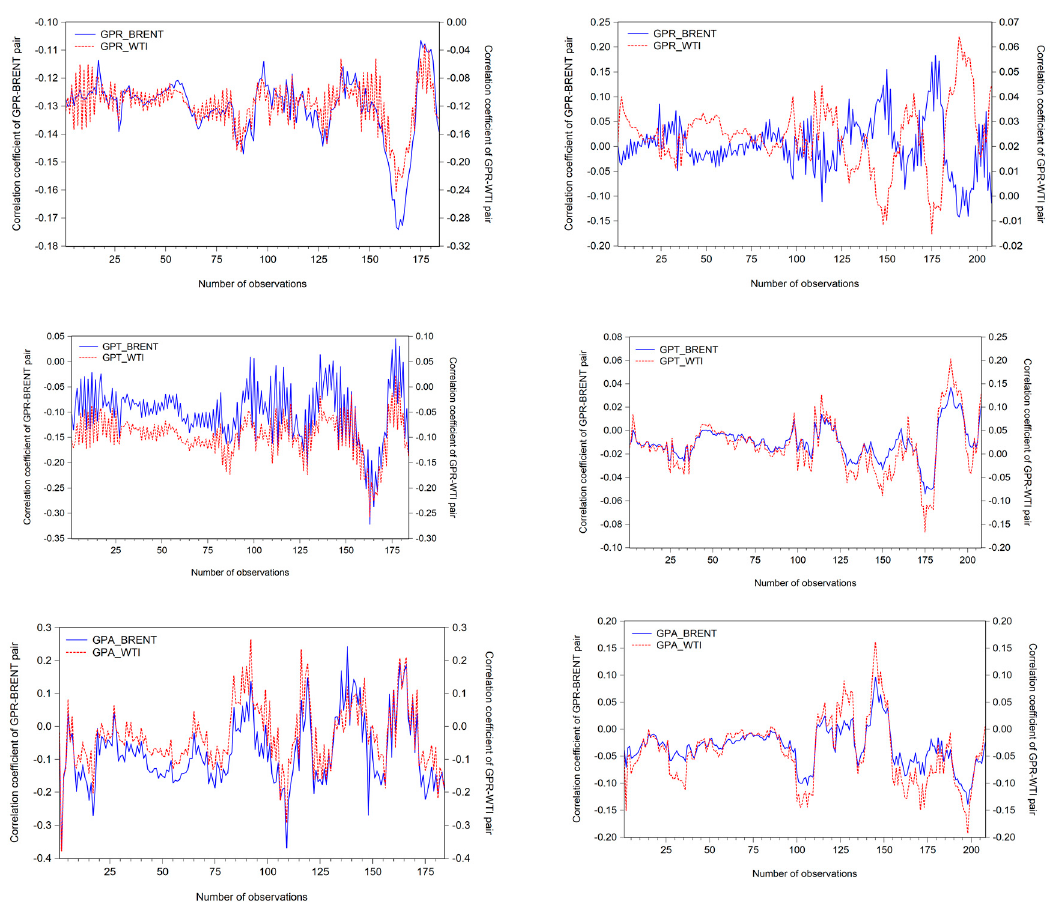
Figure 6. Dynamic correlations between geopolitical risks and crude oil prices in di ff erent political environments. Note: the sub-figure on the left presents the dynamic Kendall’s τ coe ffi cients of the GPR-Brent pair, GPR-WTI pair, GPT-Brent pair, GPT-WTI pair, GPA-Brent pair and GPA-WTI pair during tense geopolitical relation periods. The sub-figure on the right presents the dynamic Kendall’s τ coe ffi cients during moderate geopolitical relation periods. GPR-BRENT, GPR-WTI, GPT-BRENT, GPT-WTI, GPA-BRENT and GPA-WTI represent the dynamic Kendall’s τ coe ffi cients of the GPR-Brent pair, GPR-WTI pair, GPT-Brent pair, GPT-WTI pair, GPA-Brent pair and GPA-WTI pair, respectively. The sample period is from June 1987 to February